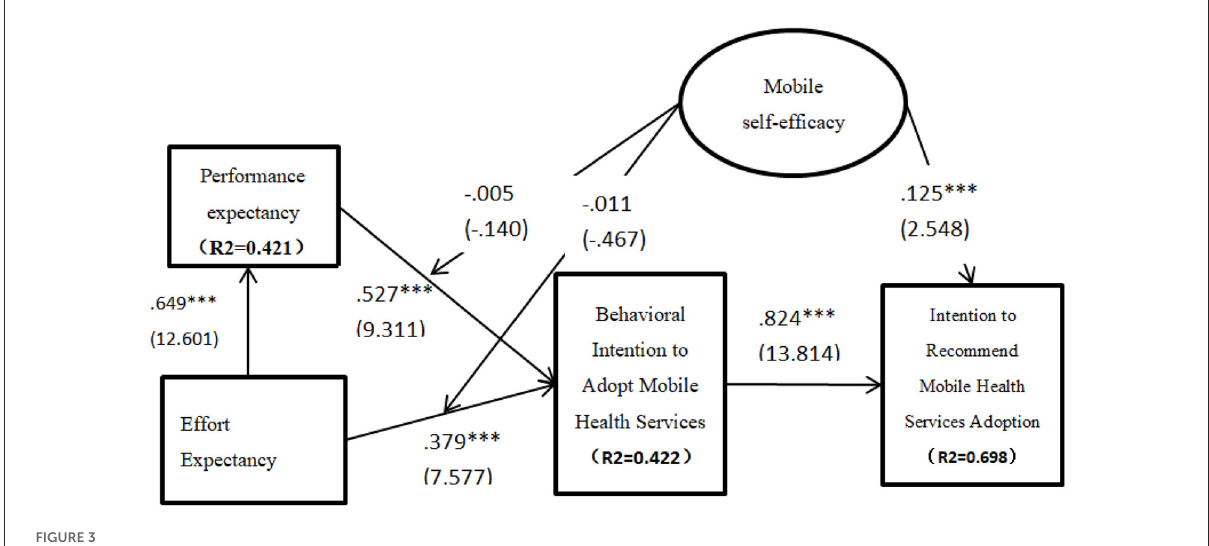
FIGURE3 Validated structural